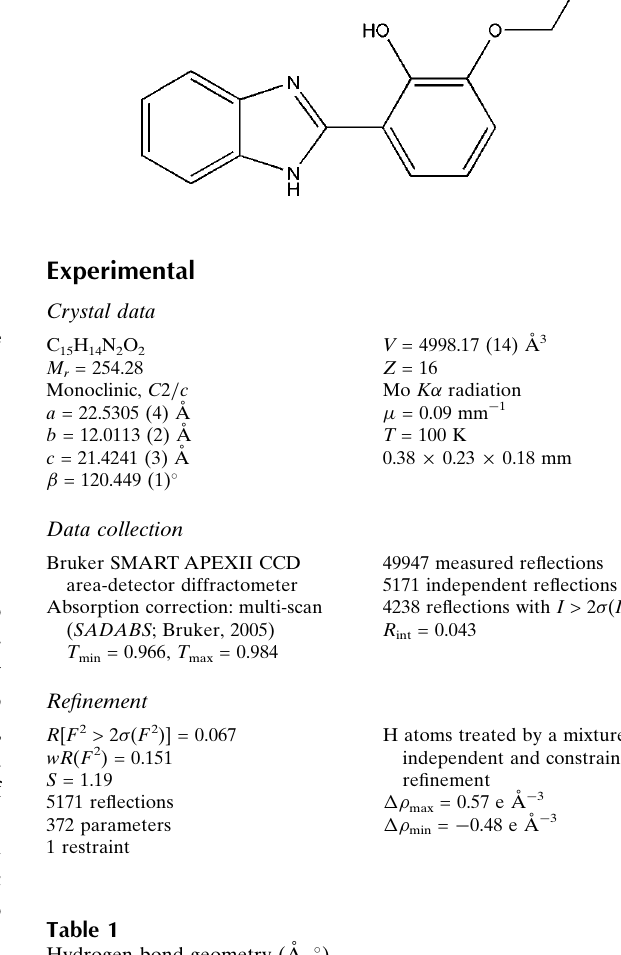
Hydrogen-bond geometry (A˚ , (cid:1) ). D —H (cid:2)(cid:2)(cid:2)